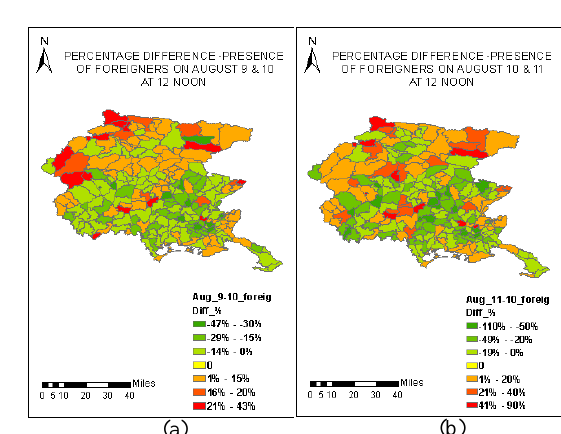
Figure 3.1.1-1 (a) Presence of Italians on August 9-10 @ 12pm (b) Presence of Italians on August 11-10 @ 12pm Figure 3.1.1- 2 (a) Presence of Foreigners on August 9-10